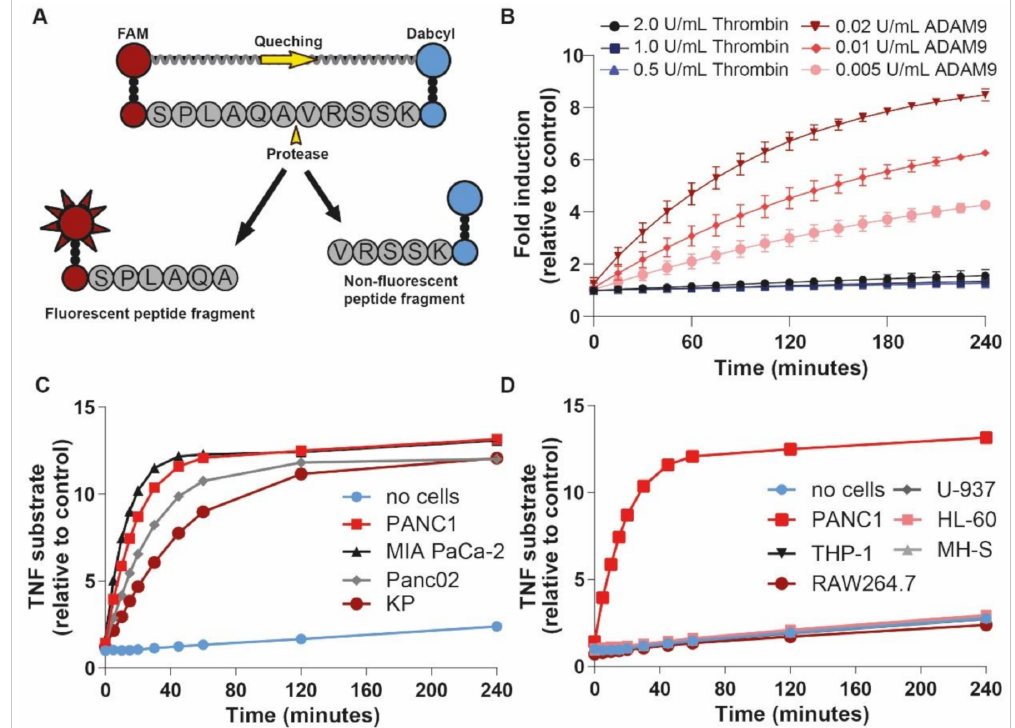
Figure 2. PDAC cells, but not leukocyte subsets, cleave ADAM9 substrates. ( A ) Schematic overview of ADAM9 substrate containing a 5’ fluorophore (FAM) and a 3’quencher (Dabcyl). ( B ) ADAM9 substrate cleavage by recombinant ADAM9 and thrombin (negative control). ( C ) ADAM9 substrate cleavage by CM derived from PDAC cells. ( D ) Lack of ADAM9 substrate cleavage by leukocyte-derived CM (with PANC1 CM as positive